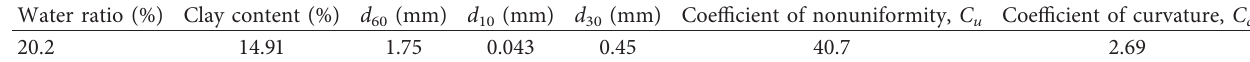
Table 1: Properties of clayey sand.